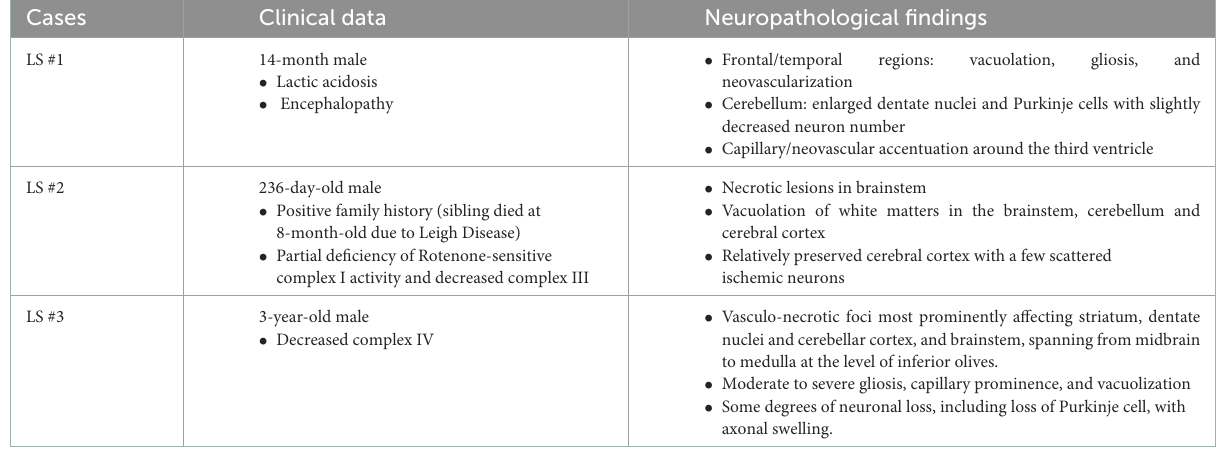
TABLE 1 Summary of clinical and pathological feature of three Leigh syndrome patients.